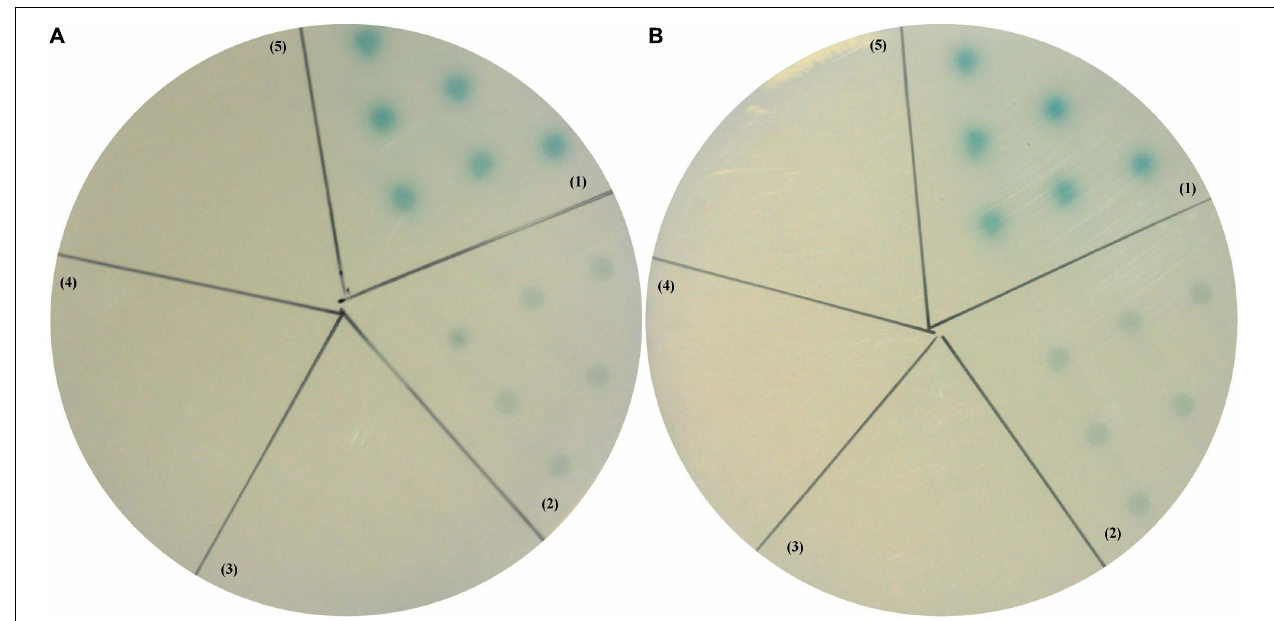
FIGURE 9 | Yeast two-hybrid assay between LvGC and LvCHH1 (A) or LvCHH2 (B) . (1) A-B, pGBK-p53 and pGAD-T-antigen for positive control; (2) A, pGAD-LvGC and pGBK-LvCHH1 plasmids; B, pGAD-LvGC and pGBK-LvCHH2 plasmids; (3) A, pGAD-T7 and pGBK-LvCHH1 plasmids; B, pGAD-T7 and pGBK-LvCHH2 plasmids; (4) A-B, pGAD-LvGC and pGBK-T7 plasmids; (5) A-B, pGBK-Lam and pGAD-T-antigen for negative